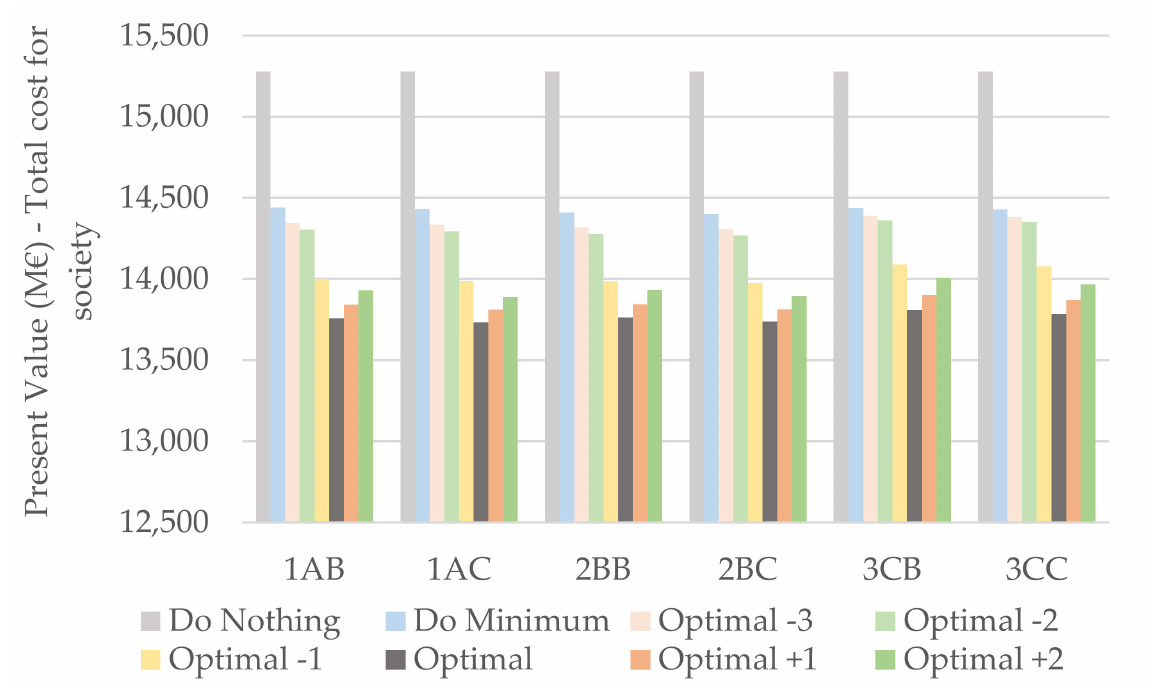
Figure 4. Present value of total road transport cost for distinct